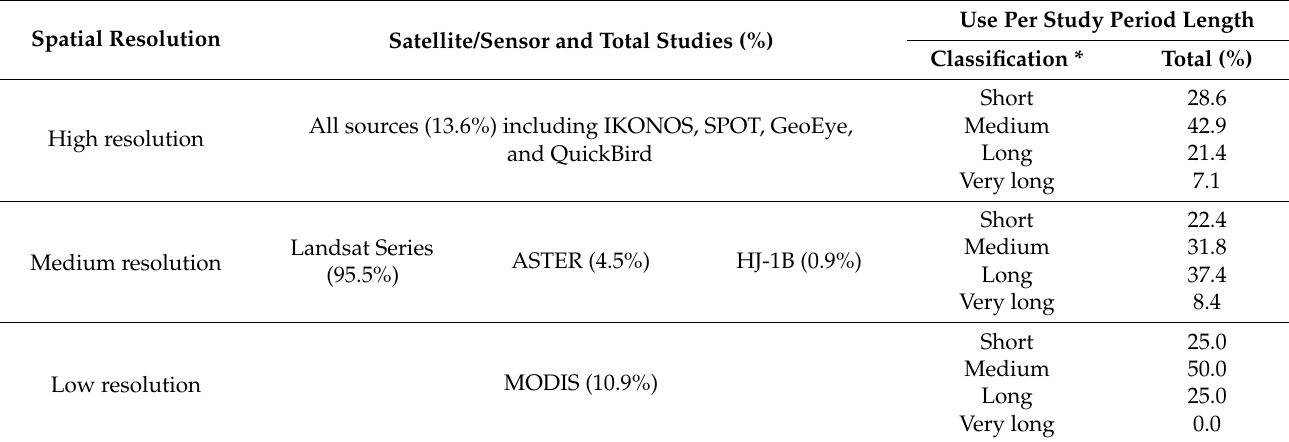
Table 2. Share of studies regarding the satellite data source used/study period considered categorized based on imagery resolution. Spatial Resolution Satellite/Sensor and Total Studies (%)